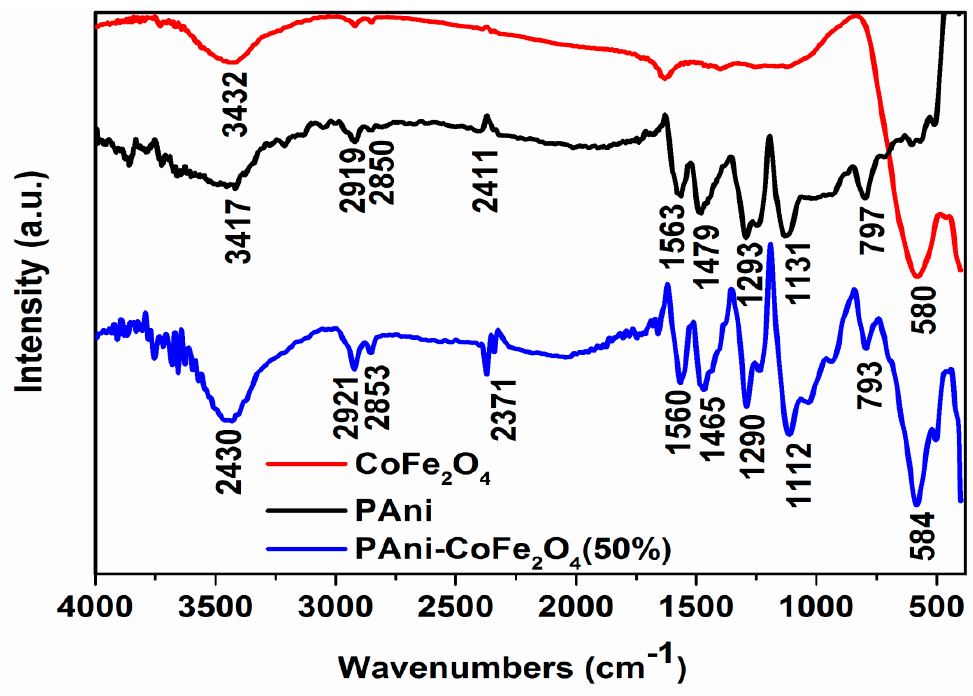
Figure 4. FT-IR of CoFe 2 O 4 , PAni and nanocomposite of PAni-CoFe 2 O 4 (50%).